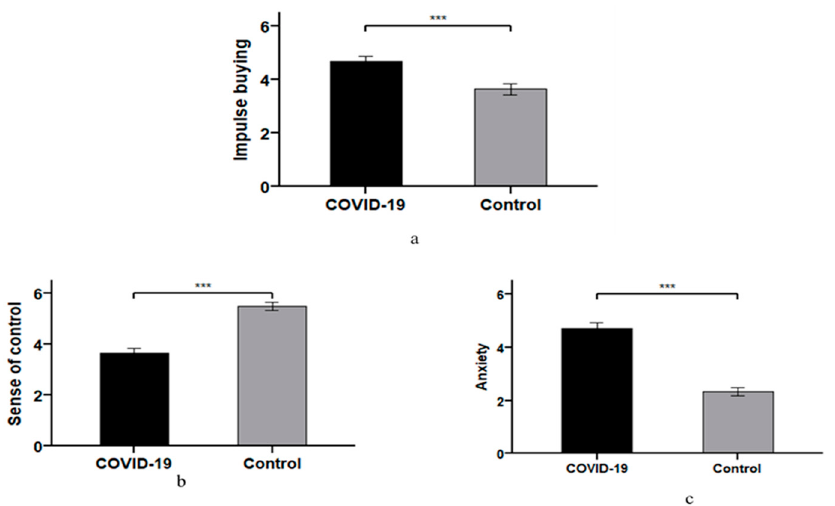
Figure 3. The impact of the COVID-19 pandemic. ( a ) The impact of the COVID-19 pandemic on impulse buying. ( b ) The impact of the COVID-19 pandemic on sense of control. ( c ) The impact of the COVID-19 pandemic on anxiety. Note: *** p <